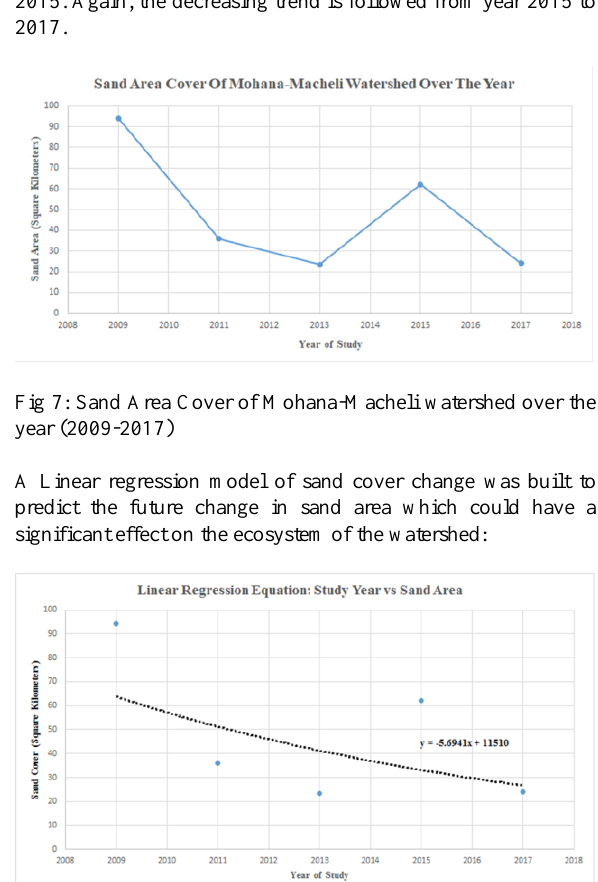
Fig 6: Sand Cover Map of Mohana-Macheli Watershed Nepal for the year 2017